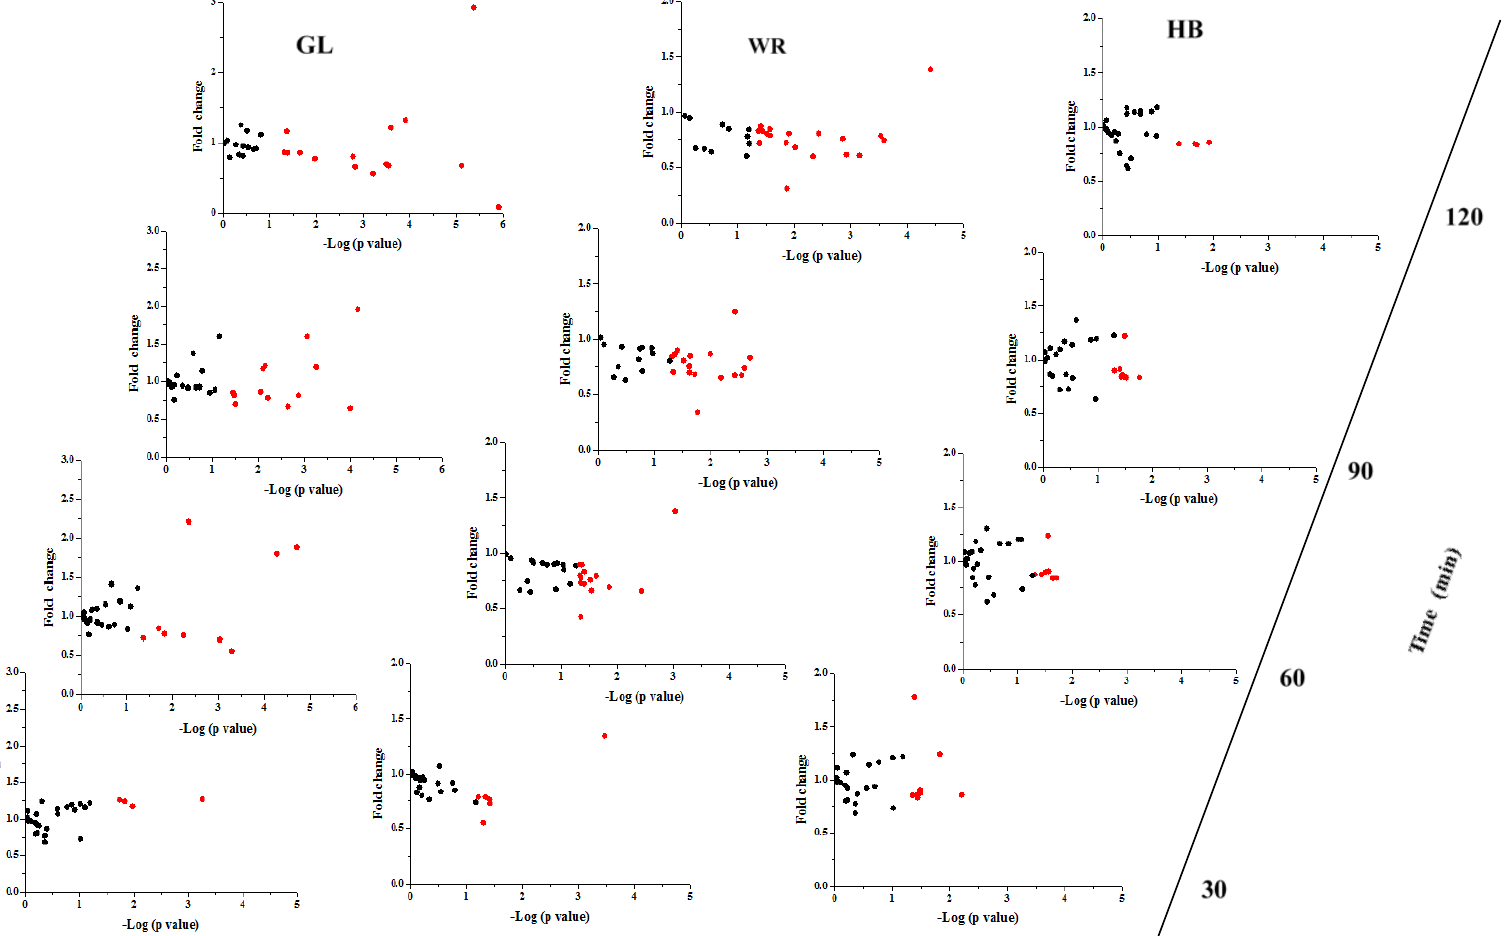
Figure 3. Fold change and significance of metabolite change in the IFG group during different test loads. Fold changes and percent changes for the metabolites (X) detected by UPLC-TQ-MS in three loads were calculated as follows: X Fold change = (X Concentration at different time (30, 60, 90, 120 min) /X Concentration at baseline ); X Percent change = (X Concentration at different time (30, 60, 90, 120 min) − X Concentration at baseline )/(X Concentration at baseline ).